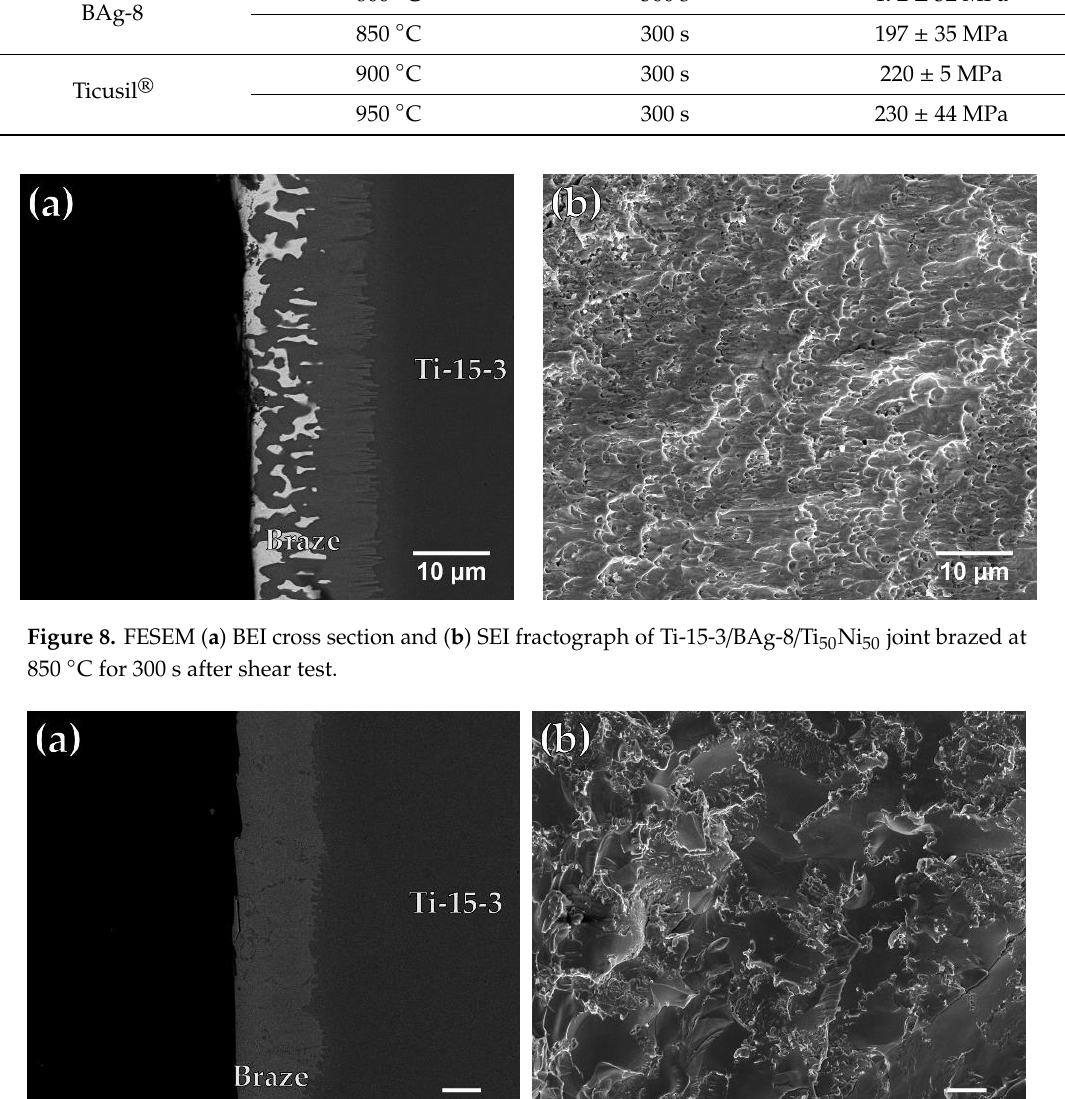
Table 6. Average shear strengths of brazed joints.